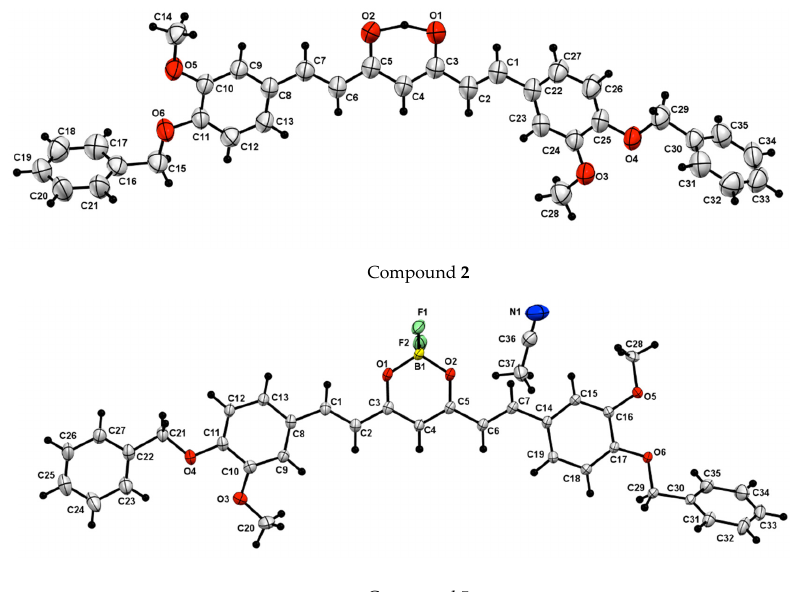
Figure 1. Crystal structures of curcumin derivatives 2 and 5 . Thermal ellipsoids are drawn at 50% probability. A detailed description of crystal structures of 2 – 5 , can be found in the Supplementary